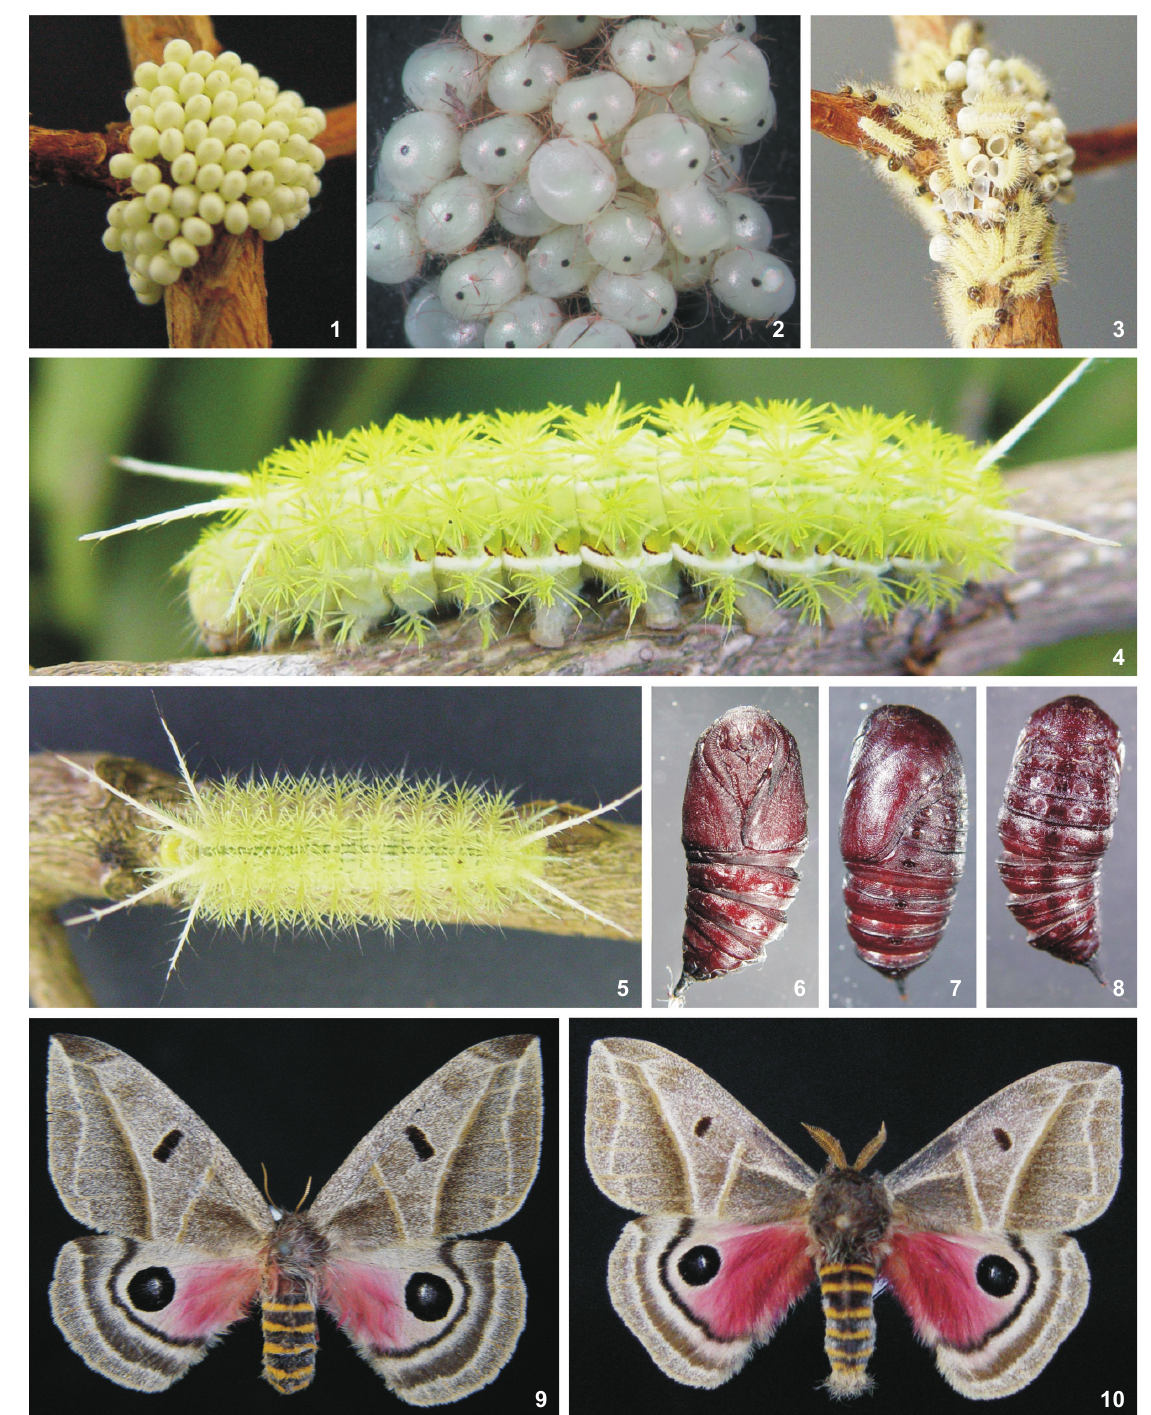
Figures 1-10. Molippa cruenta : (1) egg mass; (2) eggs in different positions; (3) larvae immediately after eclosion ; (4) last larval instar, lateral aspect; (5) last larval instar, dorsal aspect; (6) pupa, ventral aspect; (7) pupa, lateral aspect; (8) pupa, dorsal aspect; (9) adult female; (10) adult